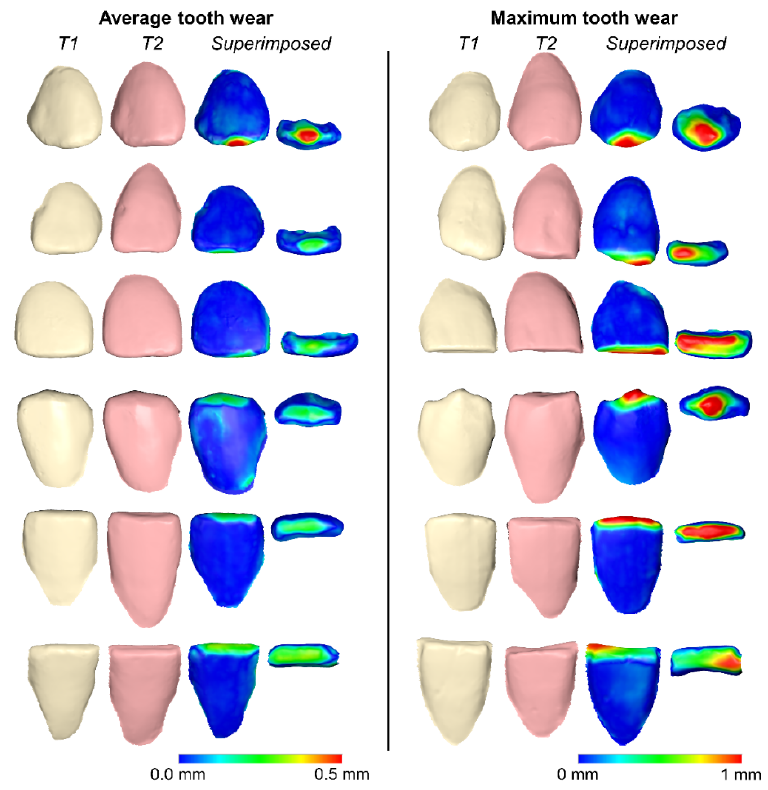
Figure 4. Three-dimensional superimpositions of serial tooth crowns and corresponding color-coded distance maps of representative cases showing the average and the maximum volumetric tooth wears detected per tooth type for the entire sample. From top to bottom: upper canine, upper lateral, upper central, lower canine, lower lateral, and lower central. T1: tooth crowns at end of orthodontic treatment. T2: the same tooth crowns as in T1, on average 13 years after T1.